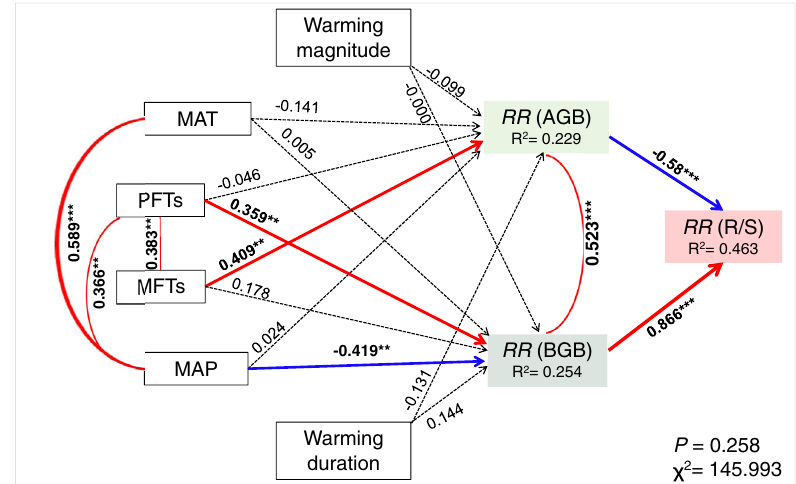
Fig.6|Pathanalysisexaminingtheeffectsofplantfunctionaltypes,dominant mycorrhizal types of root symbiosis, background climate condition, and warming treatment on the response of root:shoot ratio. PFT S plant functional types (i.e., herbsorwoody plants),MFT S dominant mycorrhizalfungitypesofroot symbiosis (i.e., AMF arbuscular mycorrhizal fungi, EMF ectomycorrhizal fungi, or AM-EMF mixed AMFand EMF), MATmeanannual precipitation, MAPmeanannual precipitation, RR (R/S) response of root:shoot ratio. The solid and dashed lines